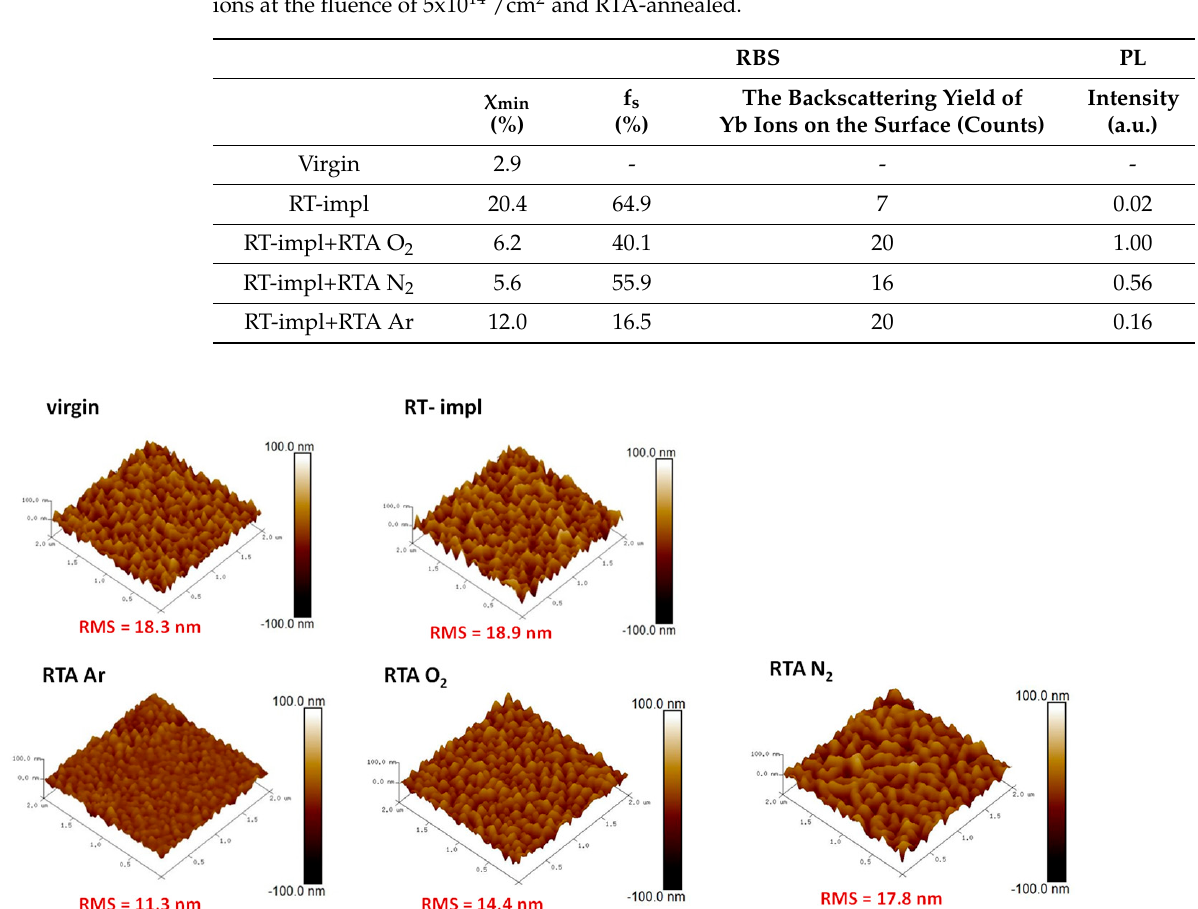
Table 2. Numerical evaluation of the RBS and PL spectra of ZnO implanted at RT with 150 keV Yb 339